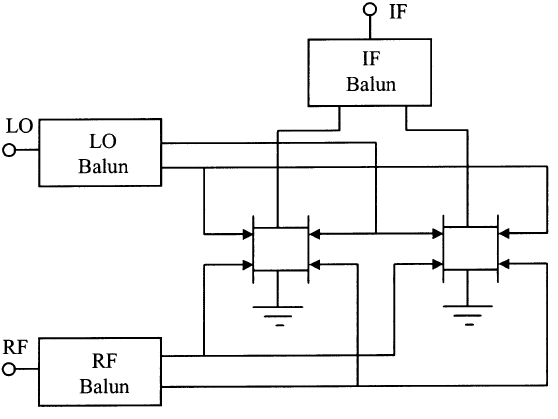
FIGURE 6 Doubly balanced dual-gate FET